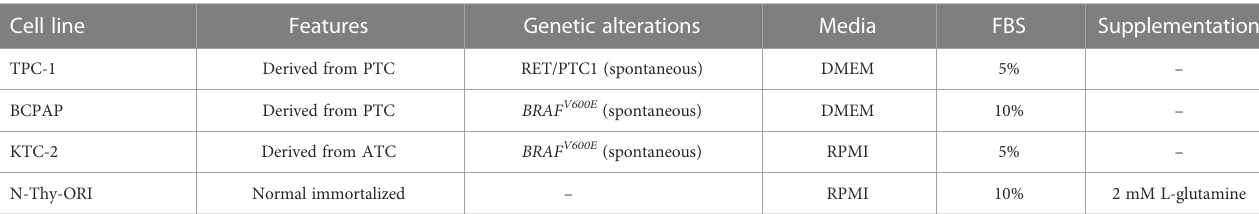
TABLE 1 Cell line features and culture